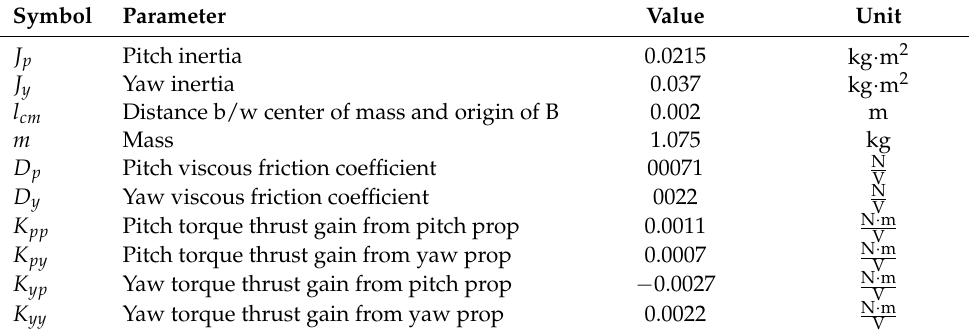
Table 1. System Parameters.